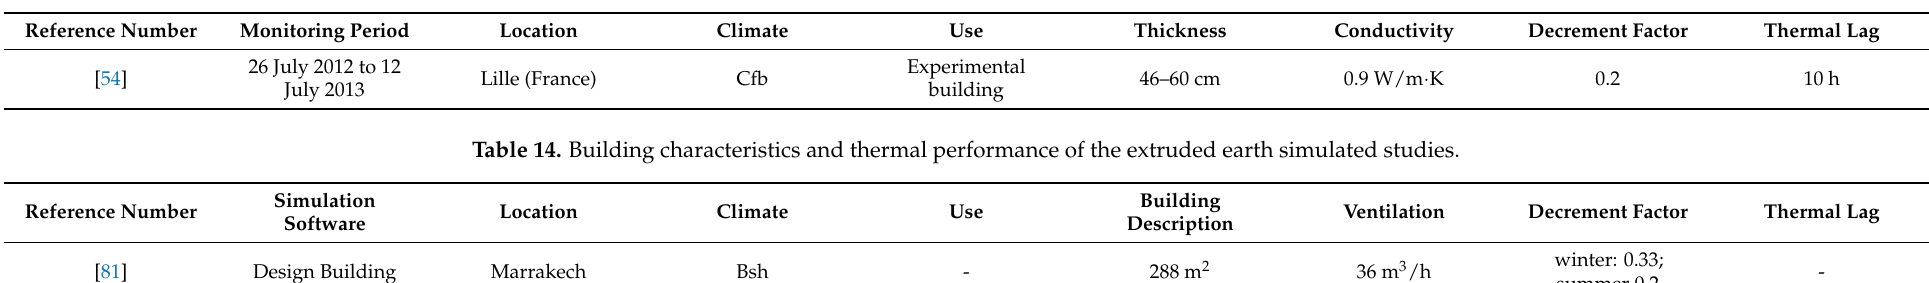
Table 13. Building characteristics and thermal performance of the extruded earth monitored studies.